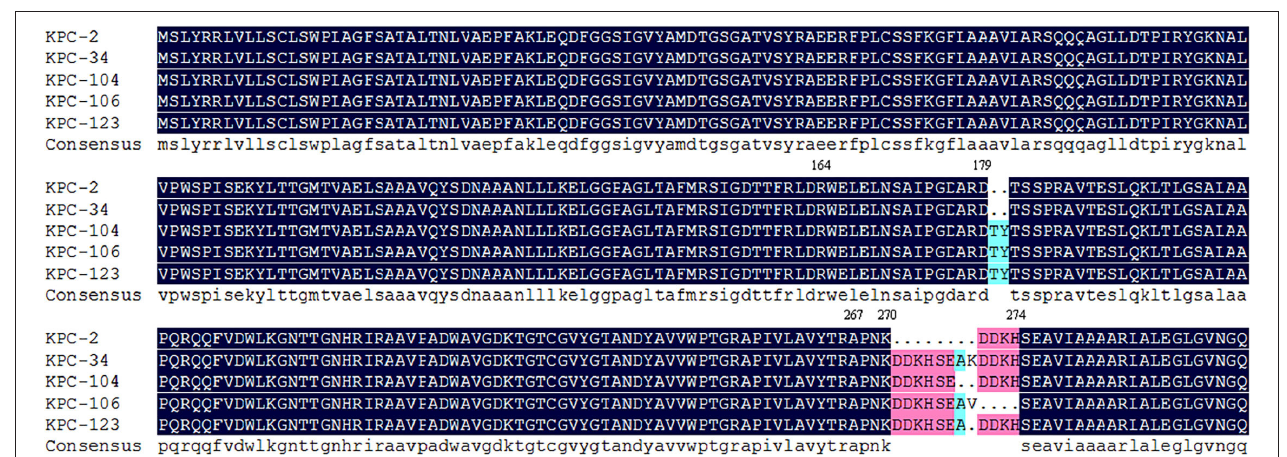
FIGURE 3 | Sequence alignment of KPC-2 and KPC variants carrying similar